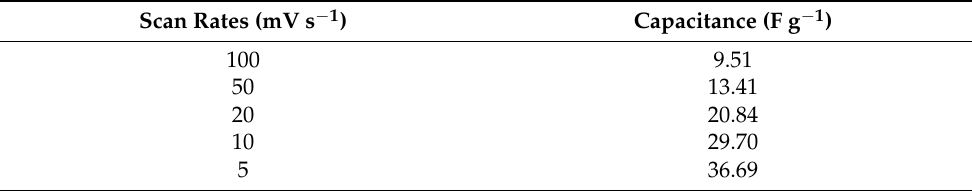
Figure 12. Cyclic voltammetry (CV) curve of the developed electrical double-layer capacitor (EDLC) for the SL4 film. Table 7. Capacitance values from cyclic voltammetry (CV) against scan